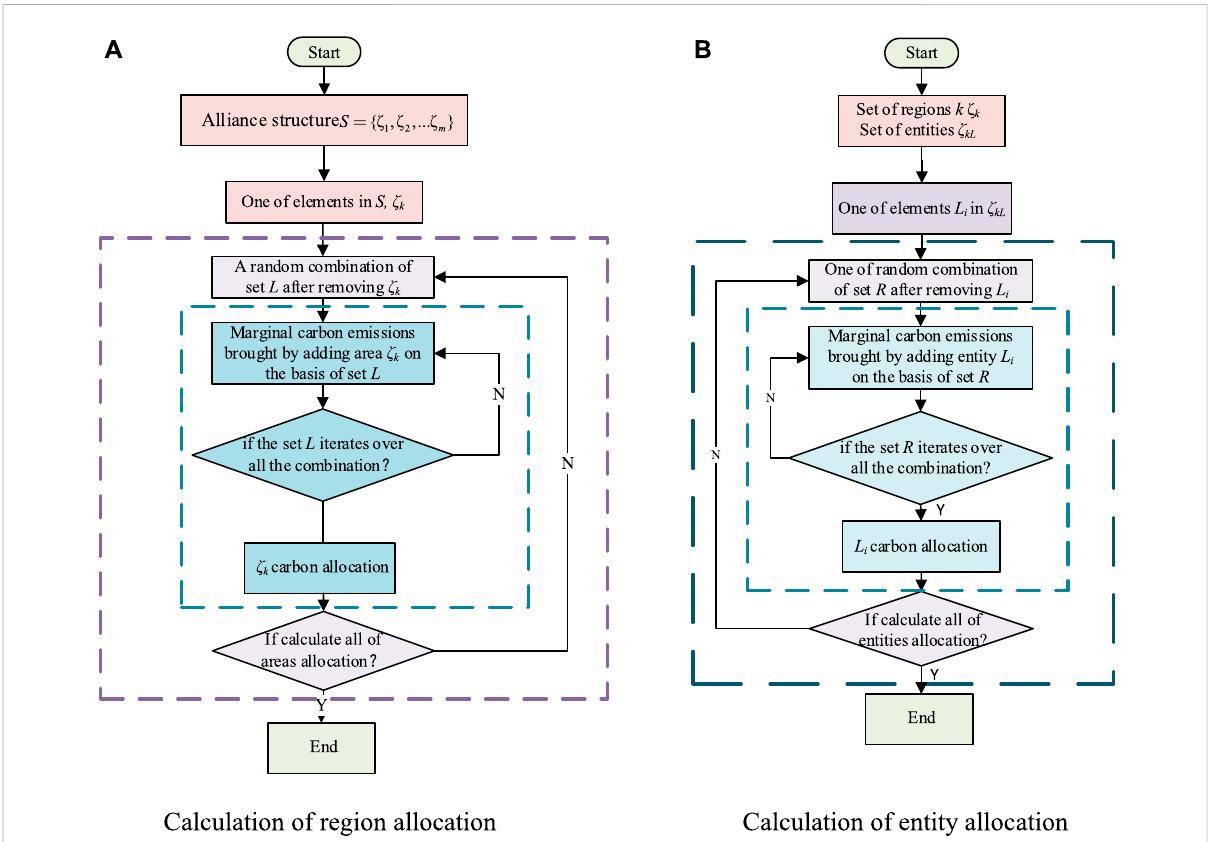
FIGURE 4 Flowchart of the Owen value method calculation process. (A) Calculation of region allocation. (B) Calculation of entity